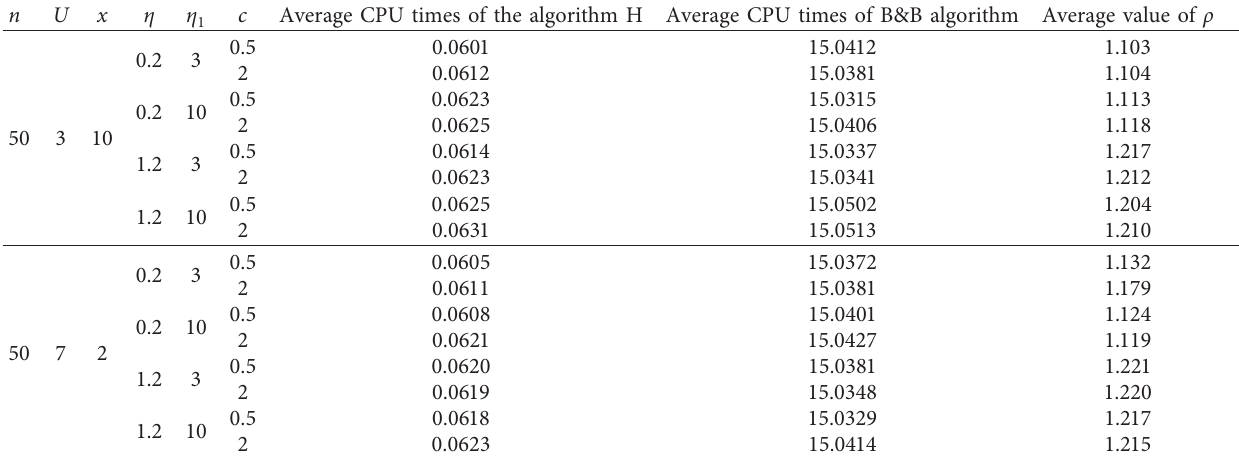
Table 6: The results of the algorithm H and branch-and-bound (B&B) algorithm for ( P 3). n U x η η 1